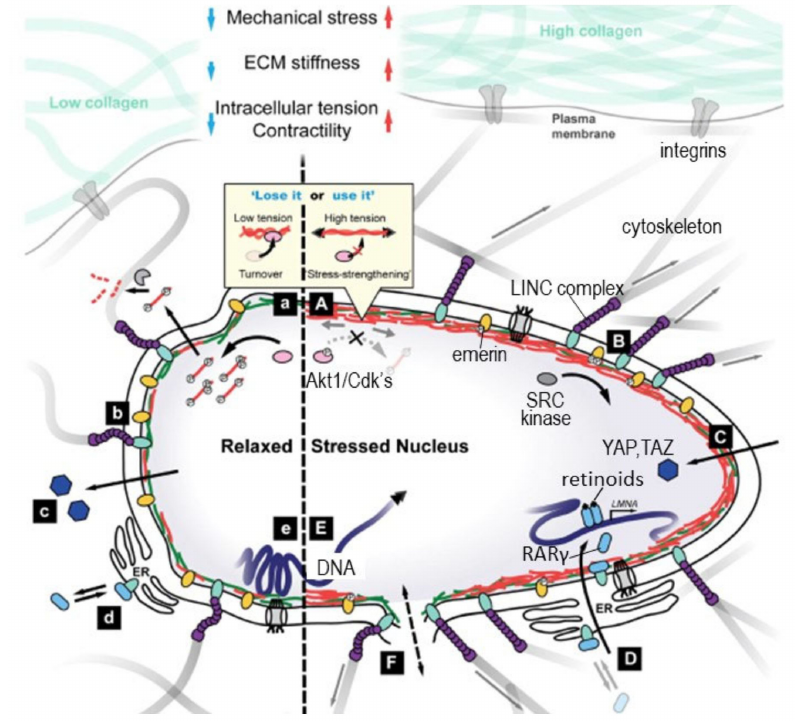
Figure 9. Mechanosensing by the nucleus. (A and a) High nuclear tension can induce conformational changes in lamin A, C and B1/B2 coiled-coil dimers, which sterically inhibits access by kinases, Cyclin-dependent kinases (Cdk’s), protein kinase C (PKC), and protein kinase B, (Akt), which would otherwise increase lamin turnover. (B and b) Pulling on nesprin-1, (the LINC complex of Nesprin and sun domain-containing protein 2 (SUN2) which tethers the nucleus to the cytoskeleton), leads to phosphorylation of emerin by non-receptor tyrosine kinase (SRC) with stress stiffening of the nucleus influencing downstream mechanoresponses: e.g., formation of stress fibres, migration, localisation of YAP and TAZ, and serum response factor transcription. (C and c) Mechanosensitive transcription factors such as YAP and TAZ, which influence growth in the Hippo pathway, (see Figure 8), translo- cate into the nucleus under stress to modulate gene expression. (D and d) Mechanical stress leads to nuclear localisation of RAR γ , (retinoic acid receptor γ ) which directly regulates LMNA (lamins A and C gene) transcription. (E and e) Application of mechanical force may lead to changes in chromatin conformation (e.g., local stretching of genes), thereby altering transcriptional activity. (F) High tension can induce membrane dilation and may lead to transient ruptures, allowing for the exchange and mislocalisation of nucleoplasmic and cytoplasmic factors. Copied and modified from Cho, Irianto, and Discher 2017 [212] under a Creative Commons License (Attribution–Noncommercial–Share Alike 4.0 International